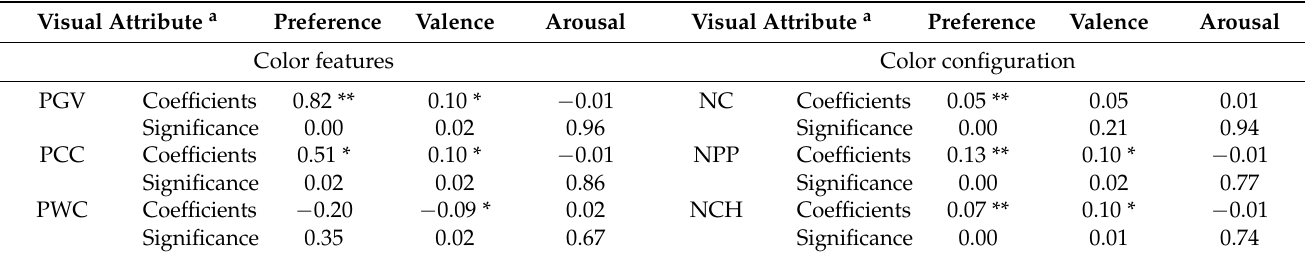
Table 4. Effects of the ‘color features’ and ‘color configuration’ factors on aesthetic preference and emotional perception. Visual Attribute a